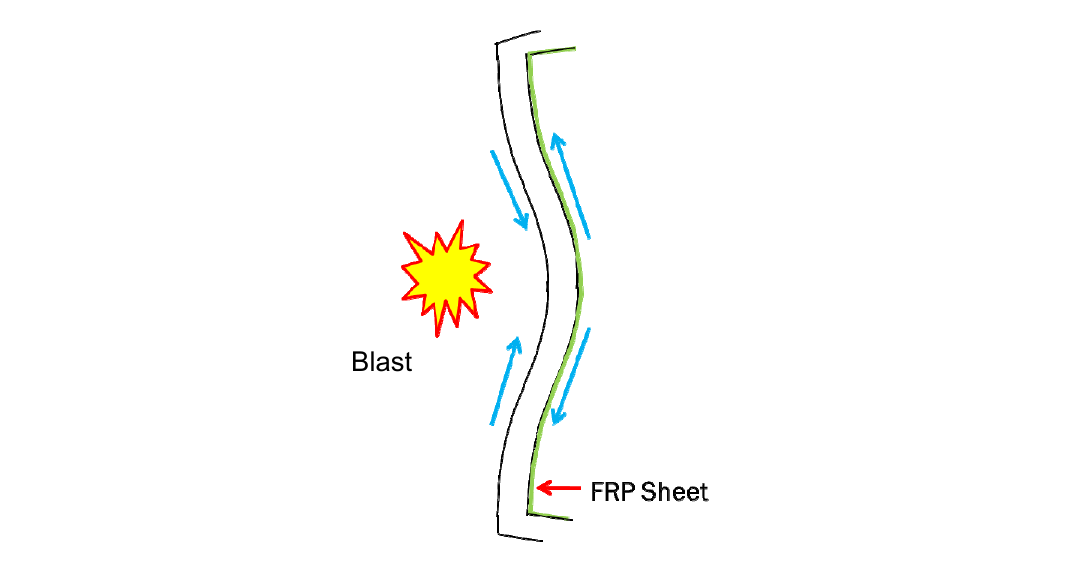
Figure 1. Fiber reinforced polymers (FRP) applied to back-face of reinforced concrete